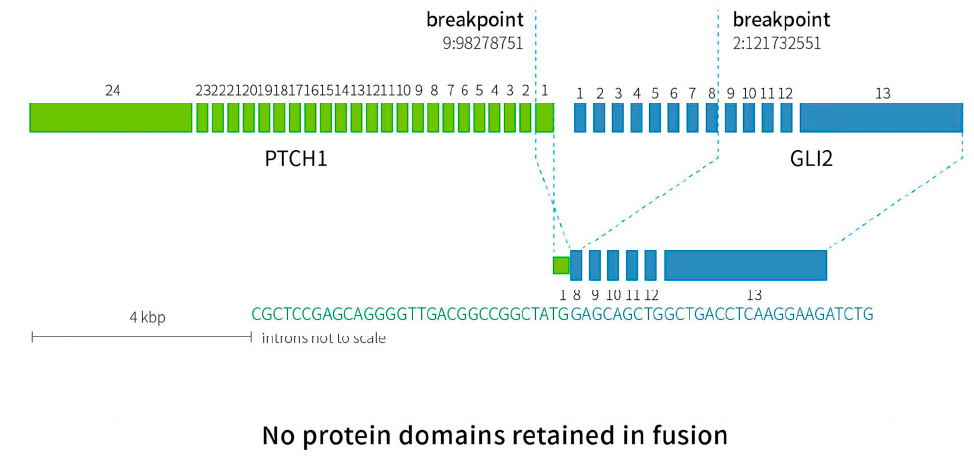
Figure 5. A diagram of RNA-based NGS results confirmed by Sanger sequencing. Inter-chromosomal fusion was identified between exon 1 of PTCH1 and exon 8 of GLI2 . Breakpoint confirmed by Sanger sequencing was indicated by dotted lines ( PTCH1 chr9:98278751, GLI2 chr2:121732551).